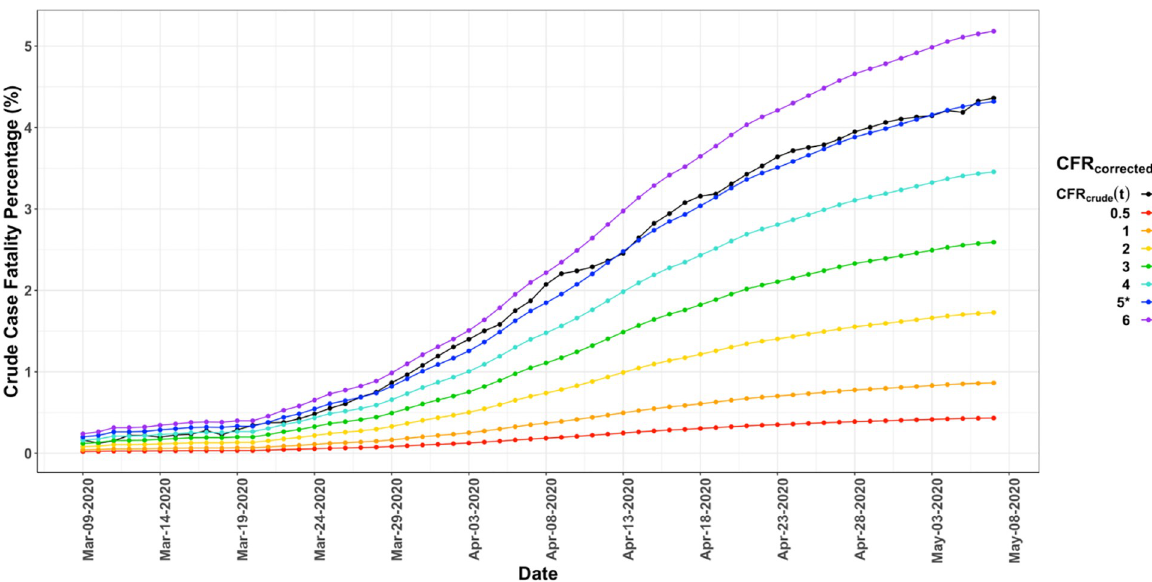
Fig 2. Simulated and reported CFR crude (t) versus time curves for Germany. The reported CFR crude (t) curve is plotted in black. Even though the reported CFR crude (t) curve rises by more than 10-fold, it is well matched throughout the duration by the simulated CFR crude (t) curve (blue) using the CFR crudetimecorrected value of 5.0% determined from the entire time course. Therefore, even early in the outbreak, when CFR crude (t) was 10-fold lower than on May 7, 2020 (the last day used) the time correction method would have accurately predicted the true CFR crude (t)